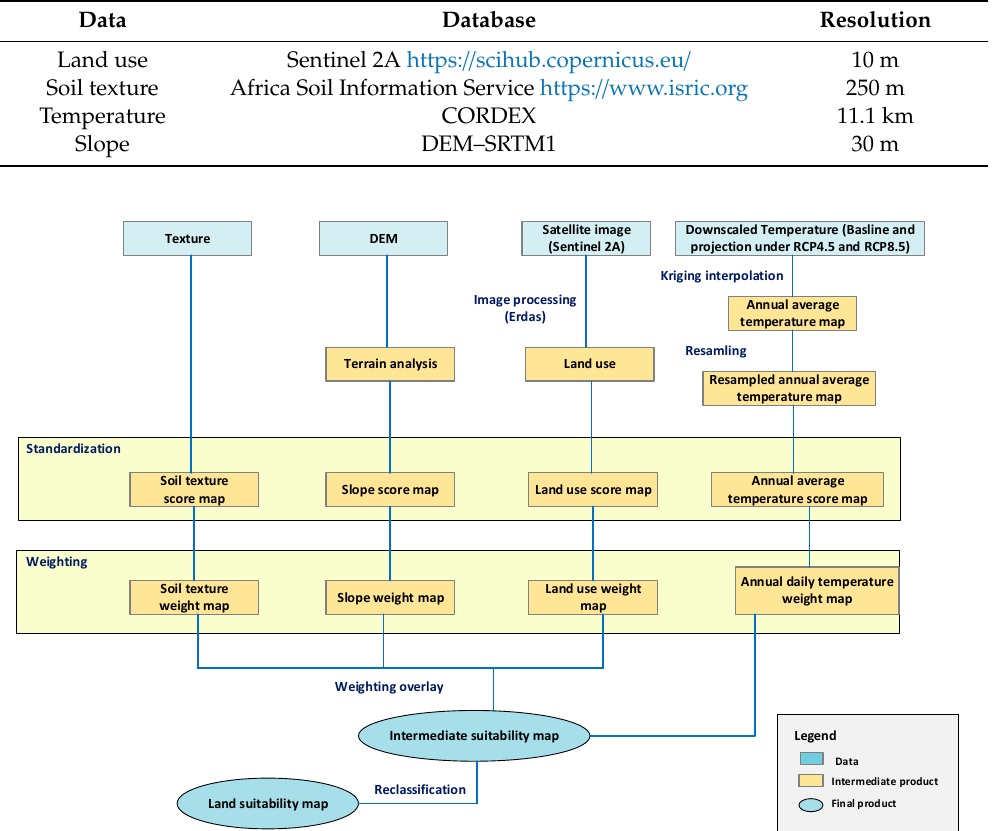
Table 2. Data collection of land suitability factors.